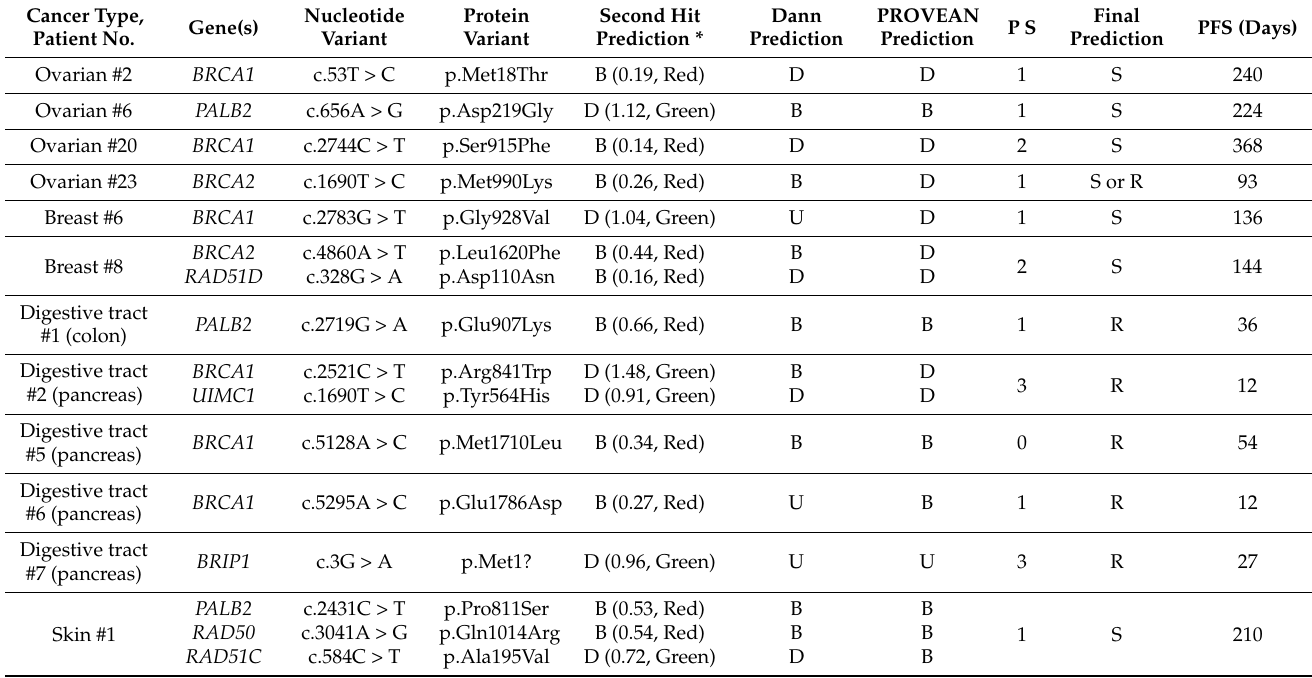
Table 3. Prediction of VUS